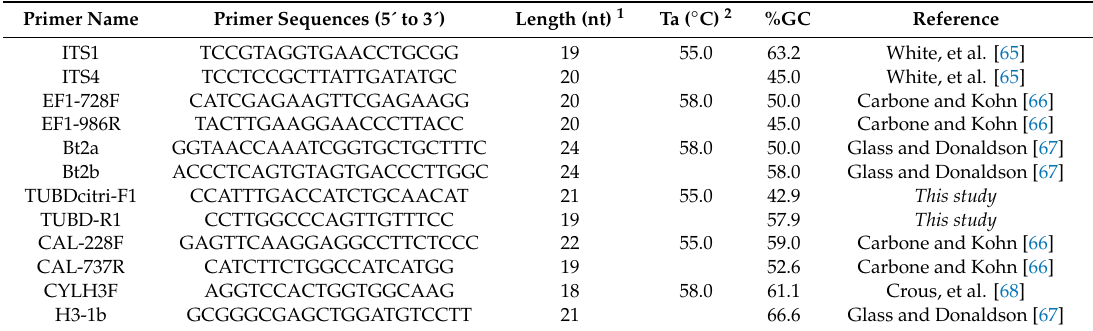
Table 3. Universal and species-specific primers used in PCR reactions with Diaporthe